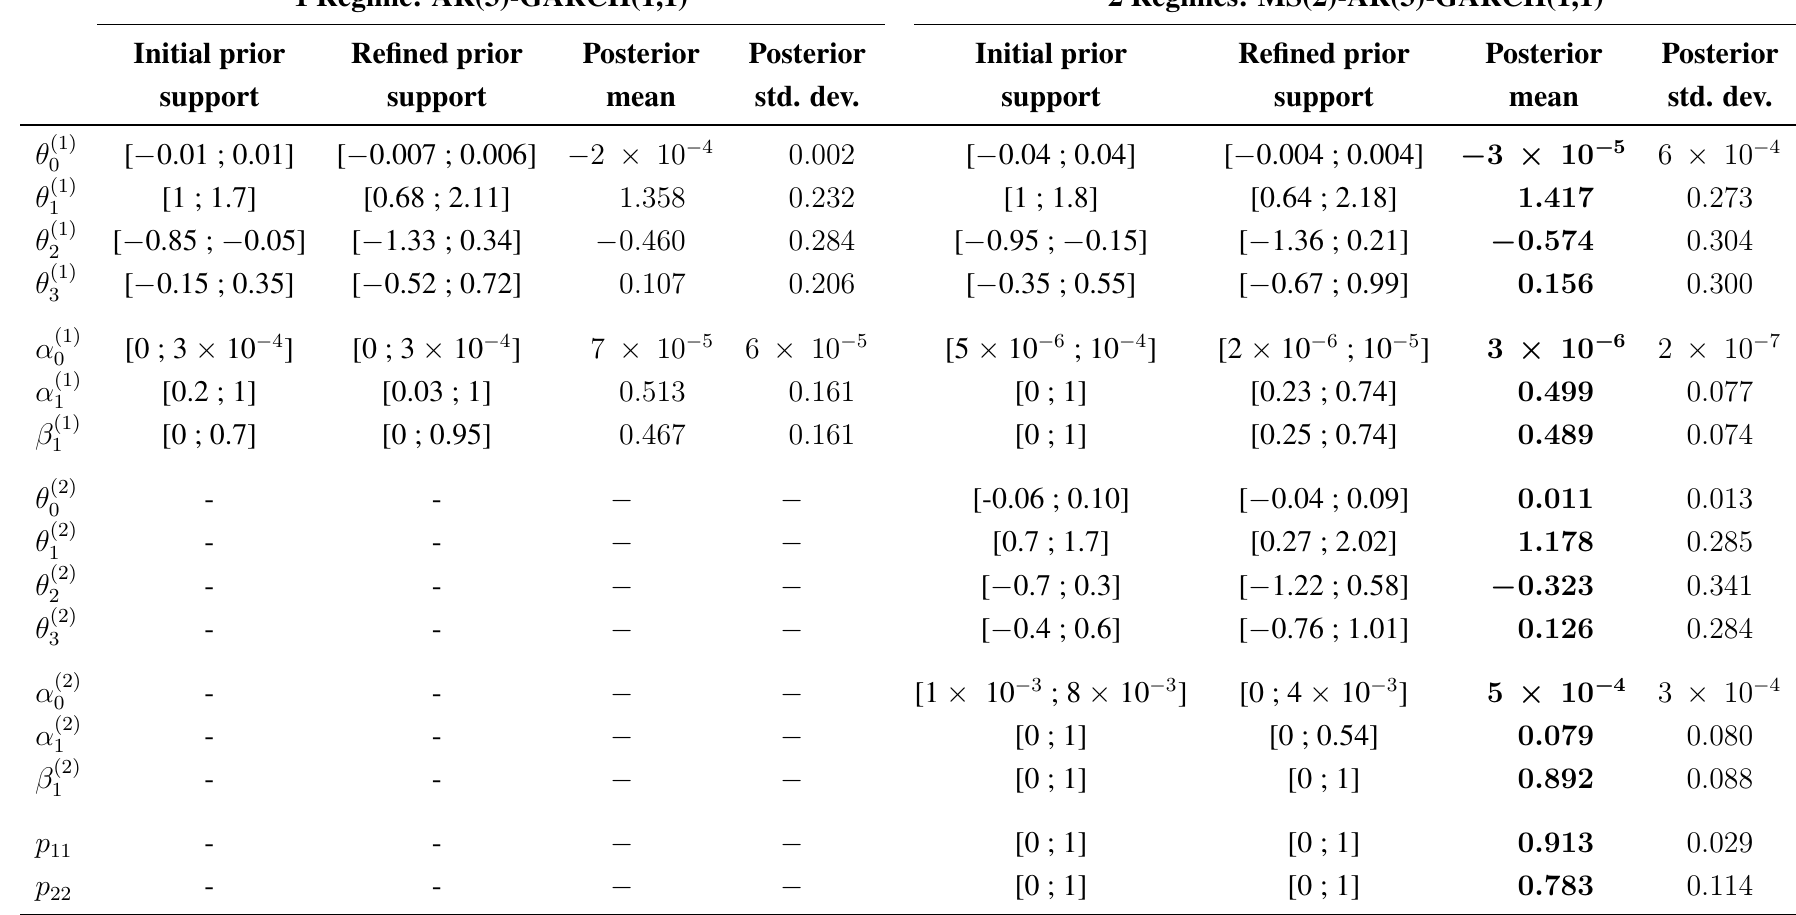
Table 3. Statistics on the posterior estimates of the AR(3)-GARCH(1,1) and MS(2)-AR(3)-GARCH(1,1) model fitted to the time series of wind